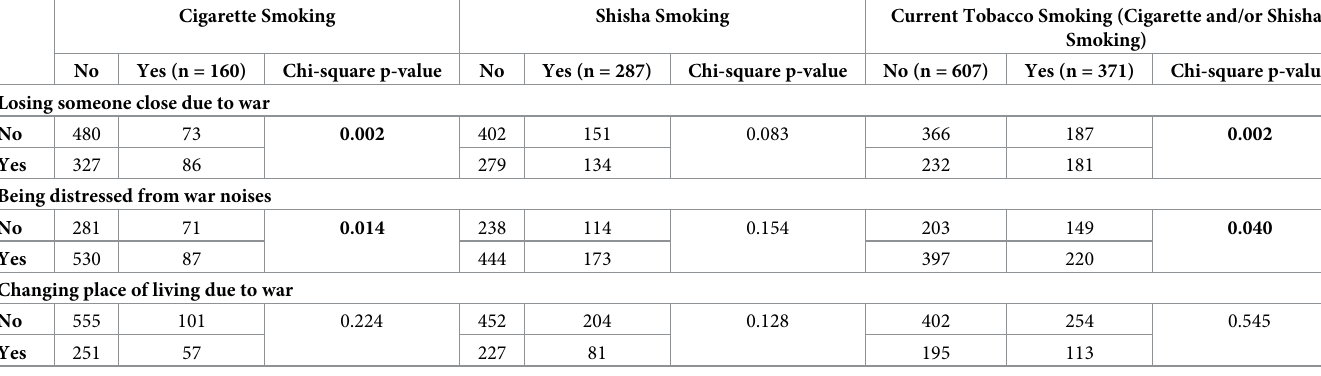
Table 3. War -related impacts among the participants according to current smoking